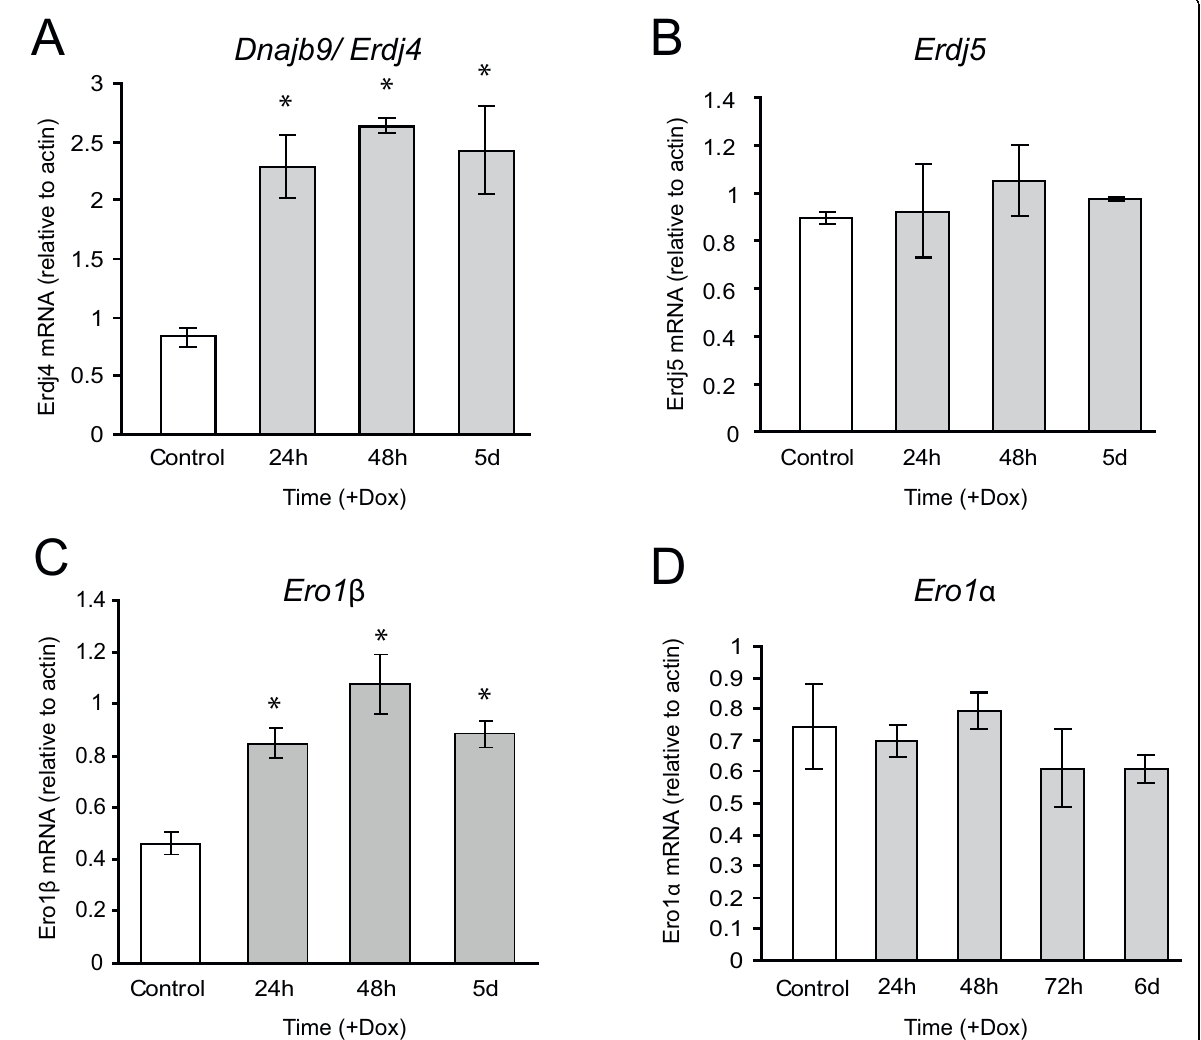
Figure 6 Expression of insulin 2(C96Y)-EGFP results in the induction of selected genes . Clone #4S2 cells were untreated (Control) or treated with 2 μ g/ml doxycycline (+Dox) for the times indicated. Total RNA was isolated and the mRNA levels relative to cellular b -actin for Erdj4/Dnajb9 (A), Erdj5/Dnajc10 (B), Ero1 b (C), Ero1 a (D) were analyzed by real-time PCR as outlined in the methods. Shown are the mean ± SE of 3 independent experiments. *p < 0.05 relative to